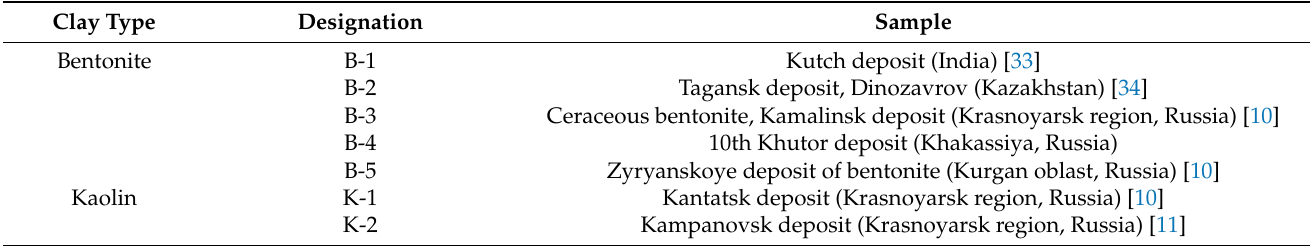
Table 1. Description of the clay